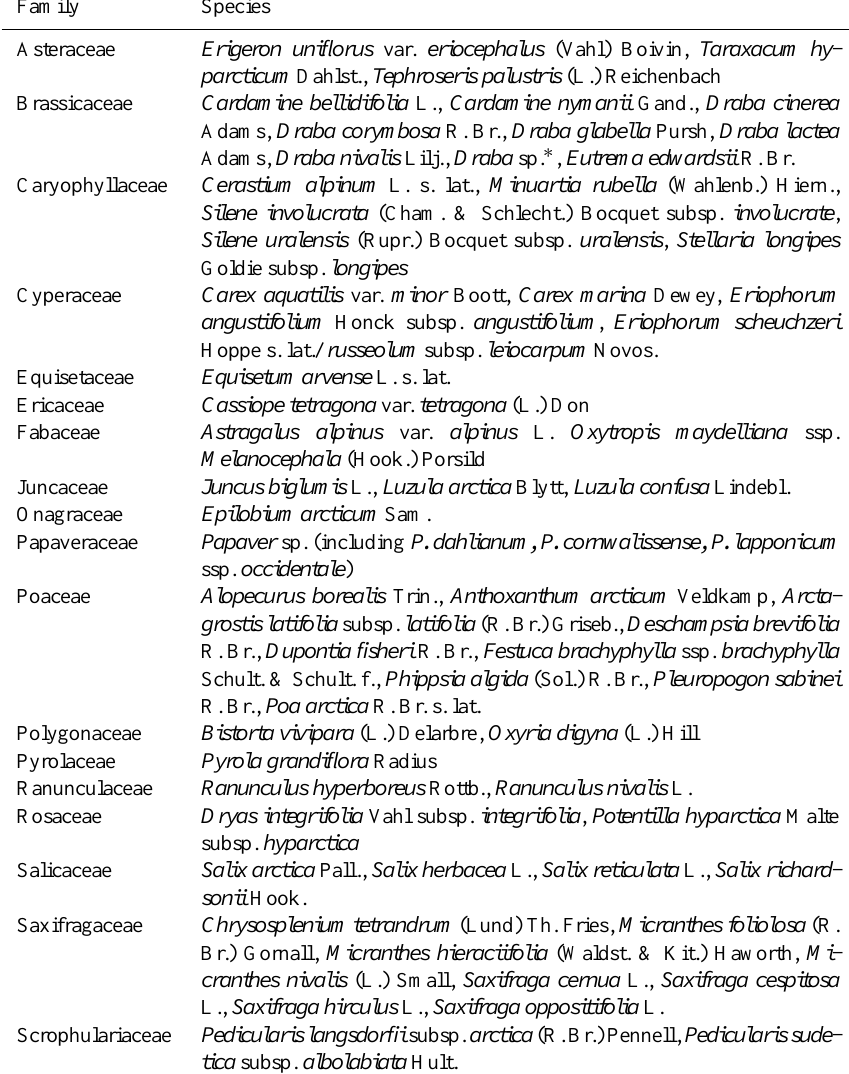
Table A2. List of the vascular plant species inventoried in the Qarlikturvik valley, Bylot Island, Nunavut during the 2009 and 2010 field seasons. Species names were retrieved (2011) from the Integrated Taxonomic Information System (ITIS)